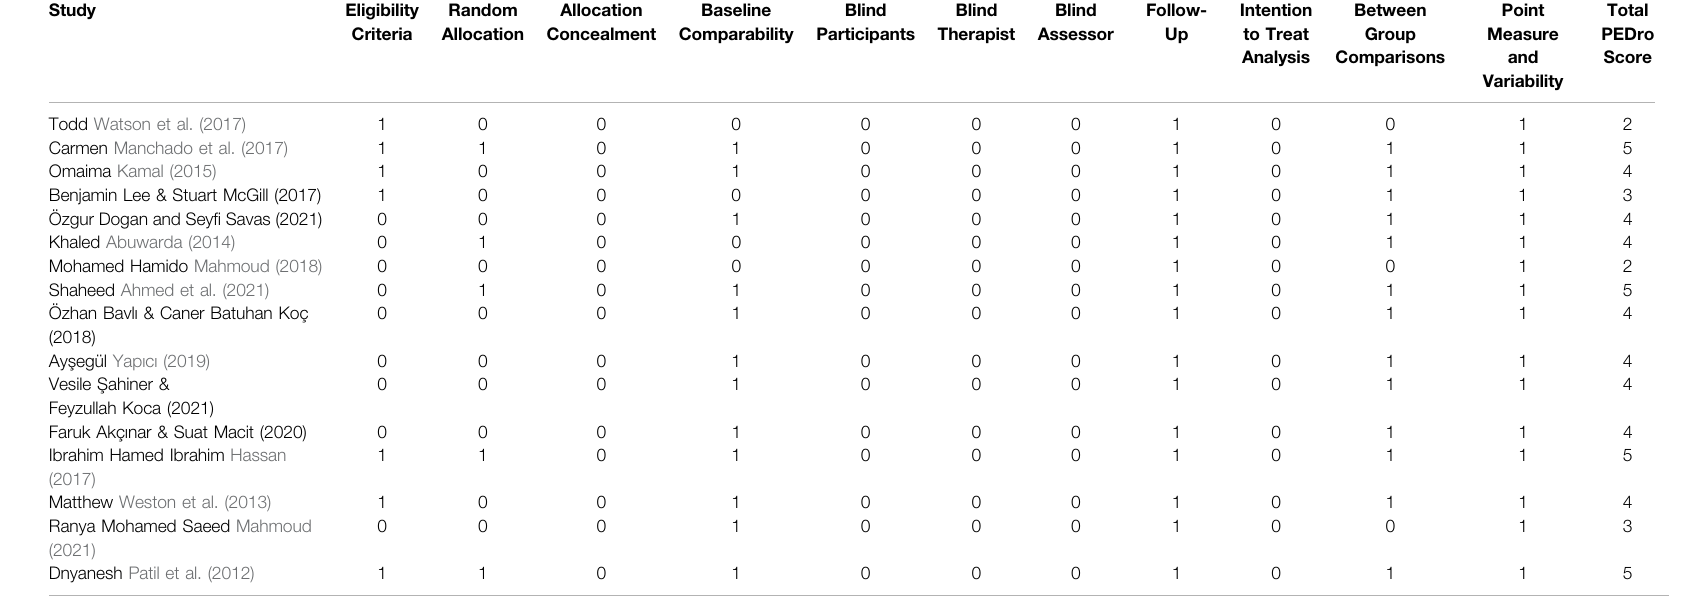
TABLE 2 | Summary of methodological quality assessment